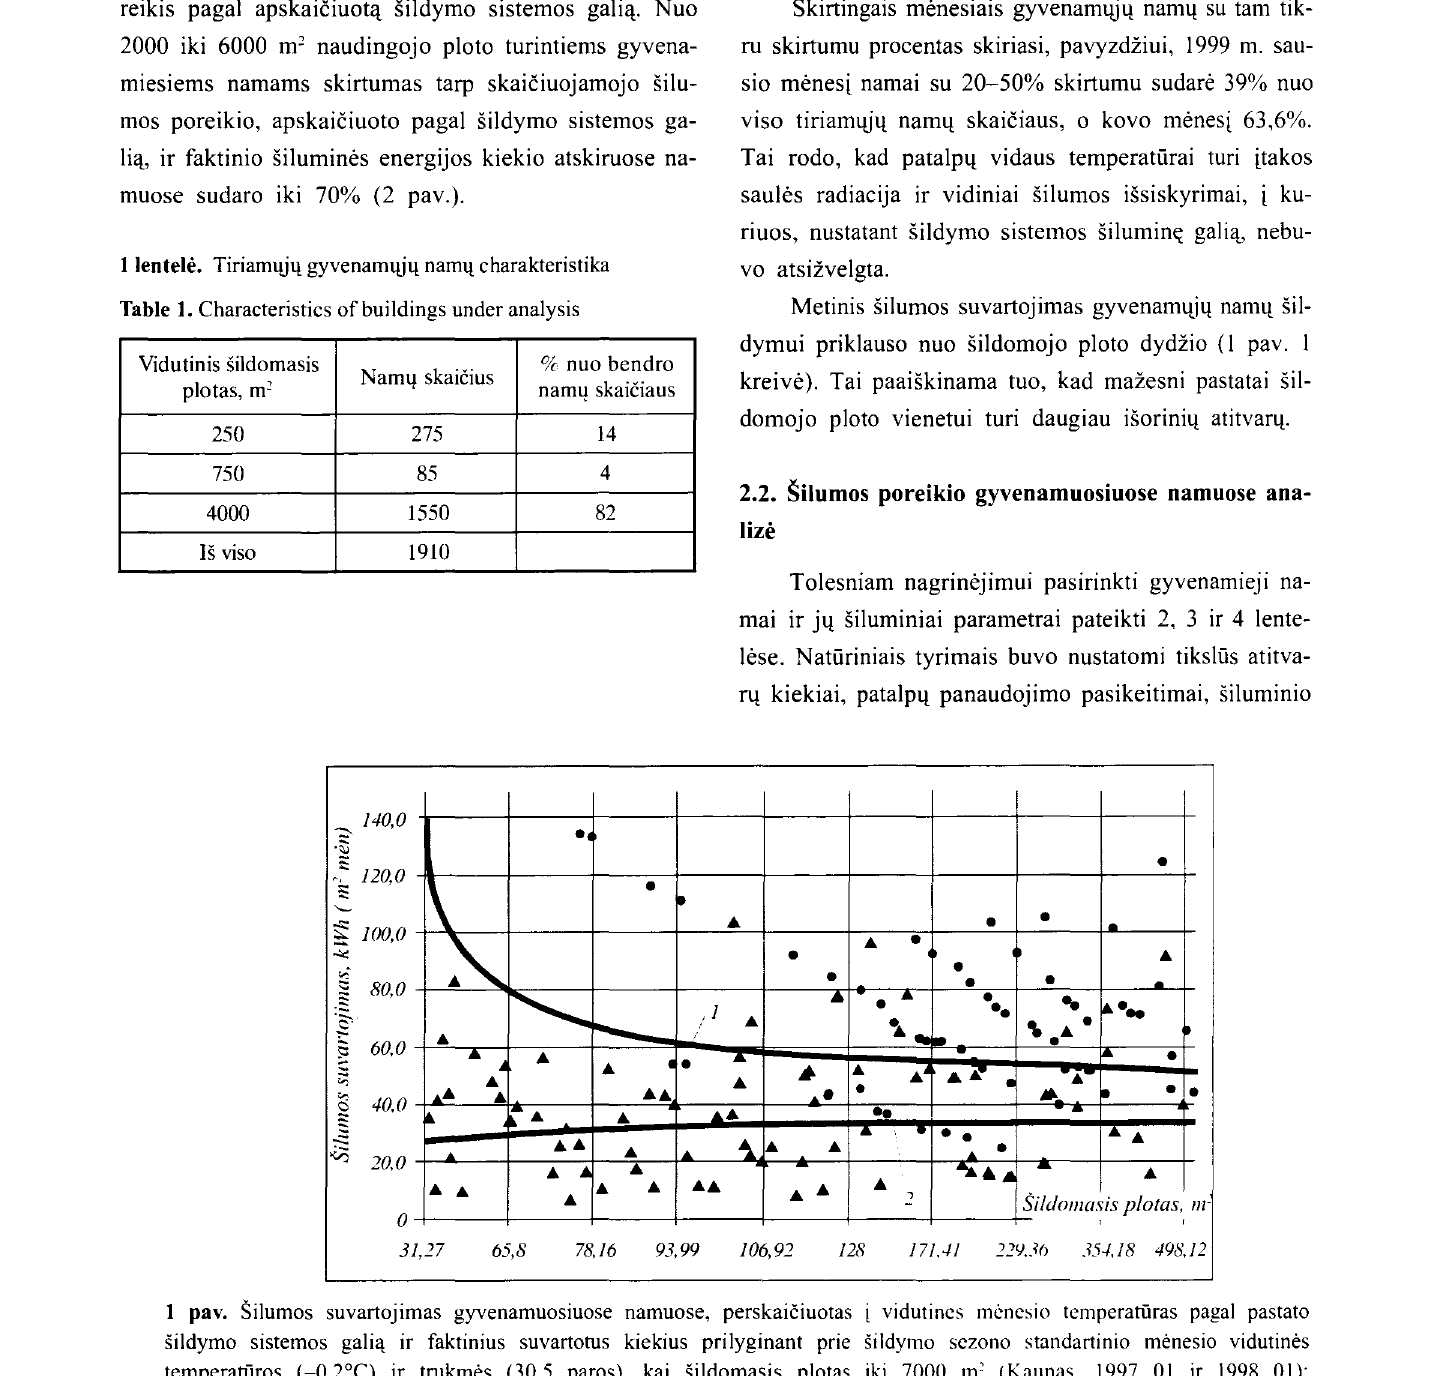
Fig I. Design and real heat consumption in apartment houses, recalculated into the standard month (average temperature conditions of heating season and duration of 30,5 days: I - design heat consumption, A - real heat consumption